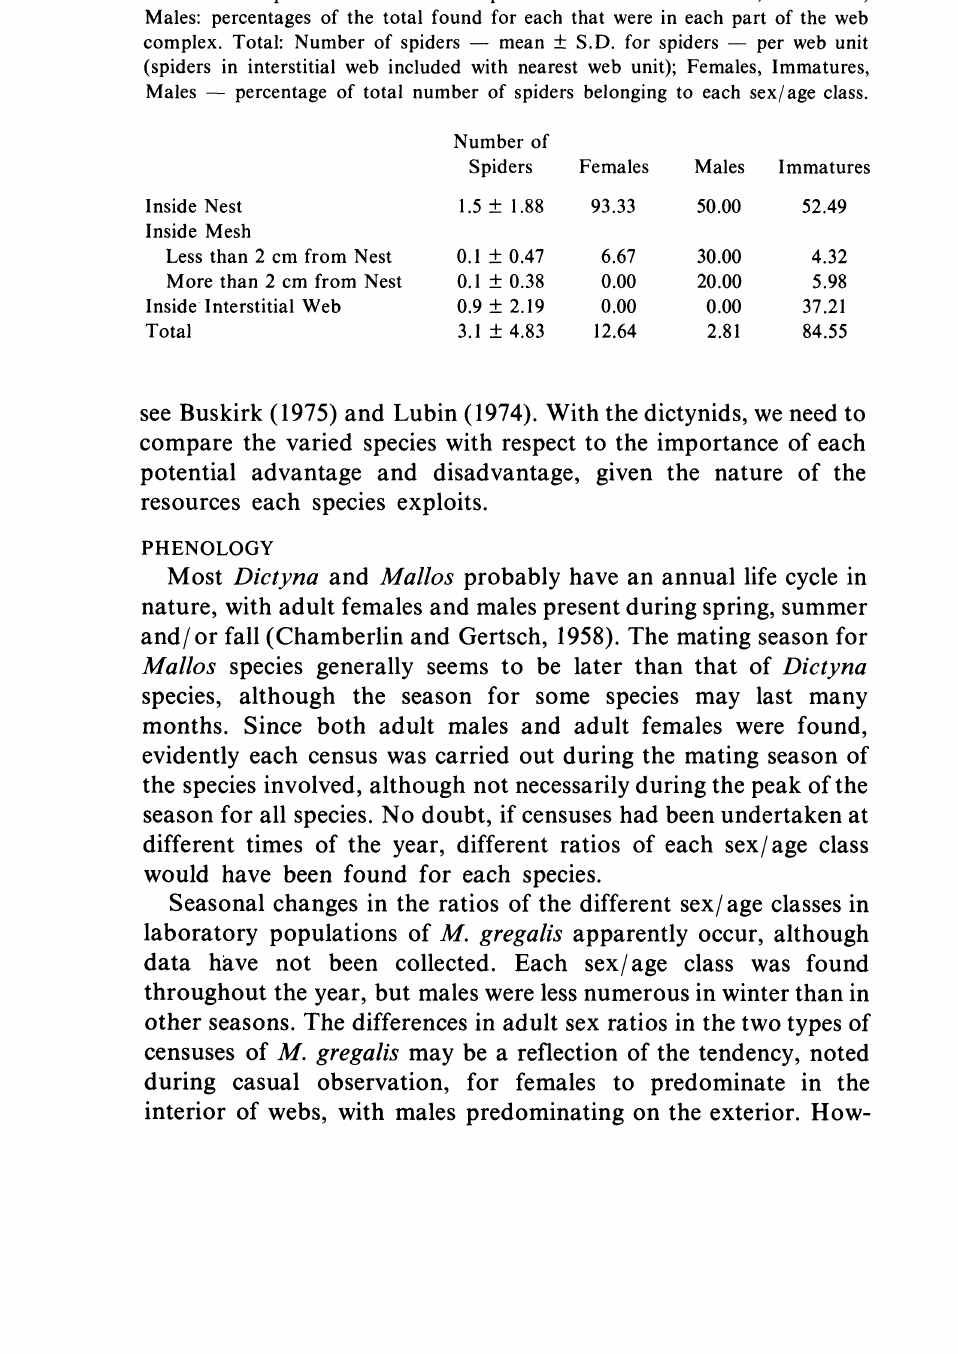
Table 4. Distribution of sex/age classes of M. trivittatus within web complexes. Based on occupied web units. No. of spiders: means + S.D. Females, Immatures, Males: percentages of the total found for each that were in each part of the web complex. Total: Number of spiders mean + S.D. for spiders per web unit (spiders in interstitial web included with nearest web unit); Females, Immatures, Males percentage of total number of spiders belonging to each sex/age class.